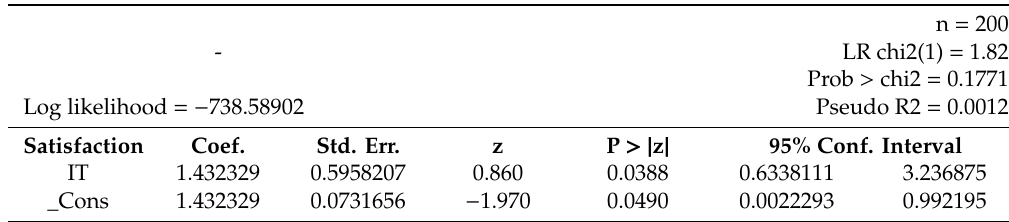
Table 7. Ordered logistic regression.